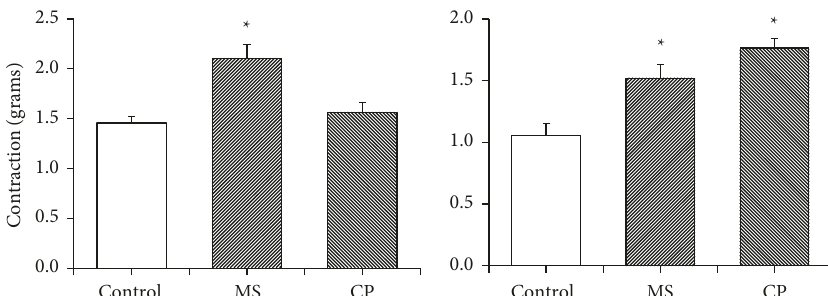
Figure 6: (a) NE-induced contraction (1 μ M) and (b) KCl-induced contraction (40 mM) in aortic rings from control rats that received tap water, metabolic syndrome (MS) rats that ingested sucrose solution during six months and critical period, and CPrats that ingested sucrose solution during postnatal days 12 to 28. Concentrations were chosen after performing a dose-response curve in previous studies. Values are means ± SEM; ∗ P < 0 . 01 versus other groups. n � 6.